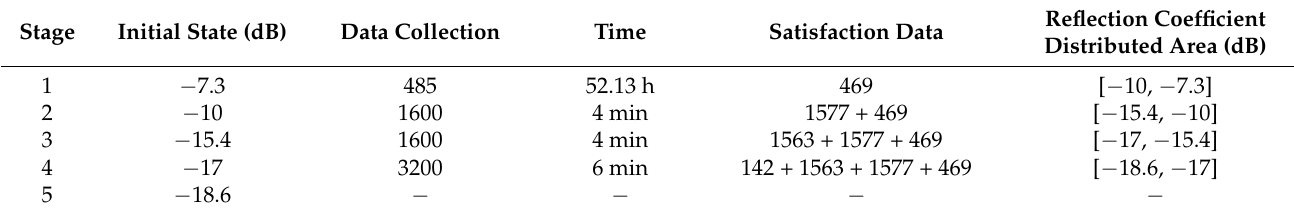
Table 3. Eighth-order cavity filter optimization